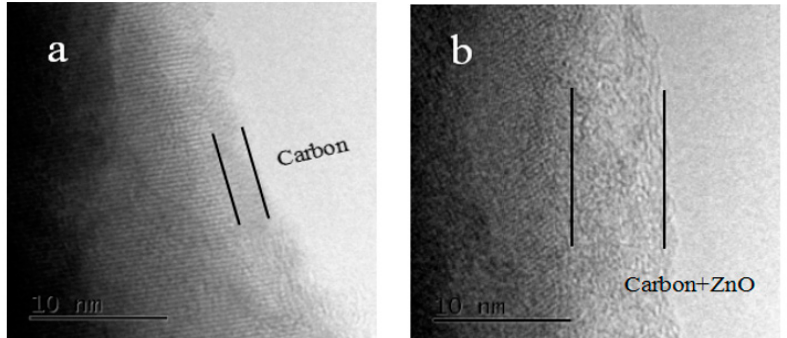
Figure 3. Elemental mapping results of LiFePO 4 /C-xZnO (x = 3 wt%) sample.